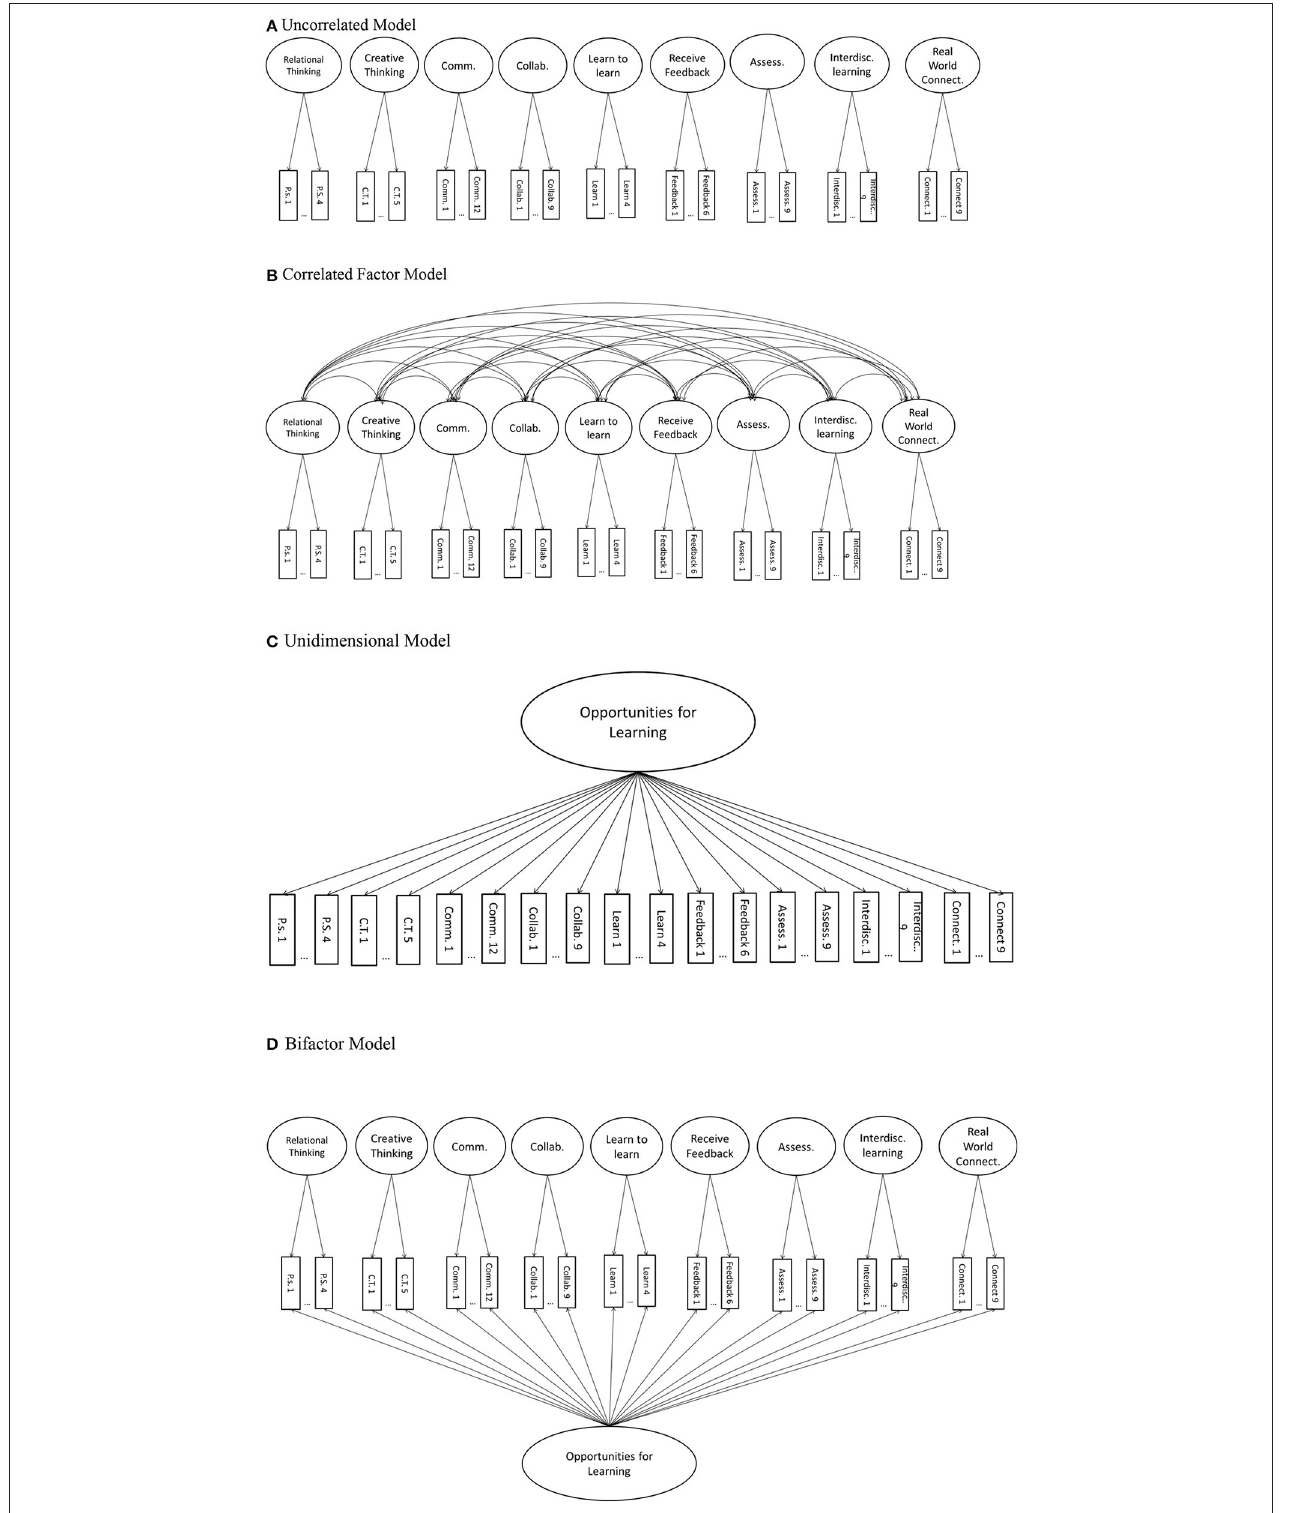
FIGURE 2 | Theoretically plausible models systematically compared at the student-level: (A) Uncorrelated; (B) Correlated; (C) Unidimensional and, (D) Bifactor models. These dimensional specifications hold for both naïve and design-based analyses. Error terms are not depicted here for simplicity.